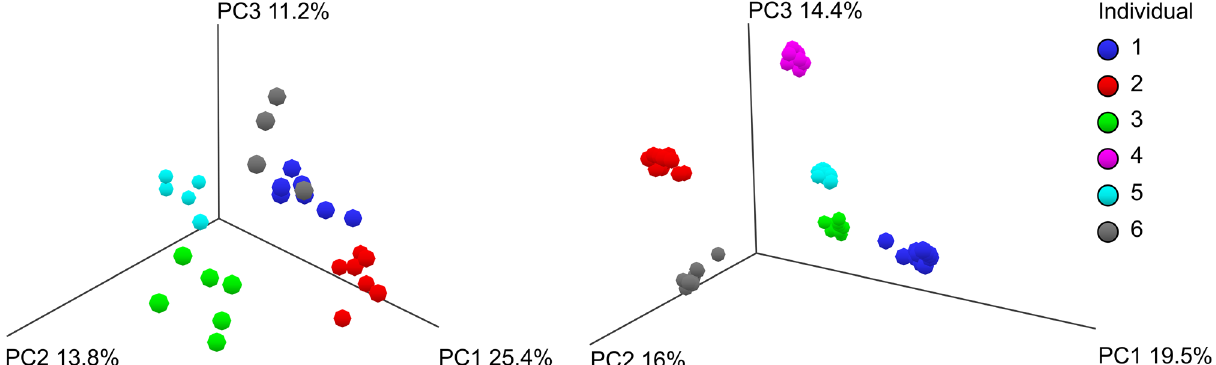
Figure 1. Clustering of microbiome communities per individual from all directly frozen stool samples collected per individual. Plots show the mycobiome ( A ) of each individual is less distinct than bacteriome ( B ). Data was CLR transformed and ordination based on Euclidian